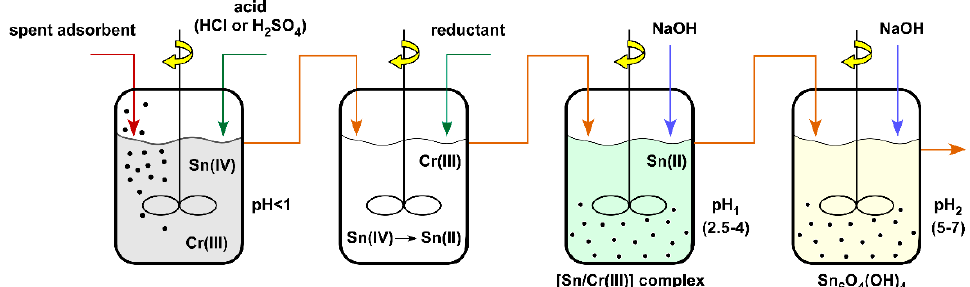
Figure 1. Experimental setup for the reconstruction of adsorbent Sn 6 O 4 (OH) 4 .